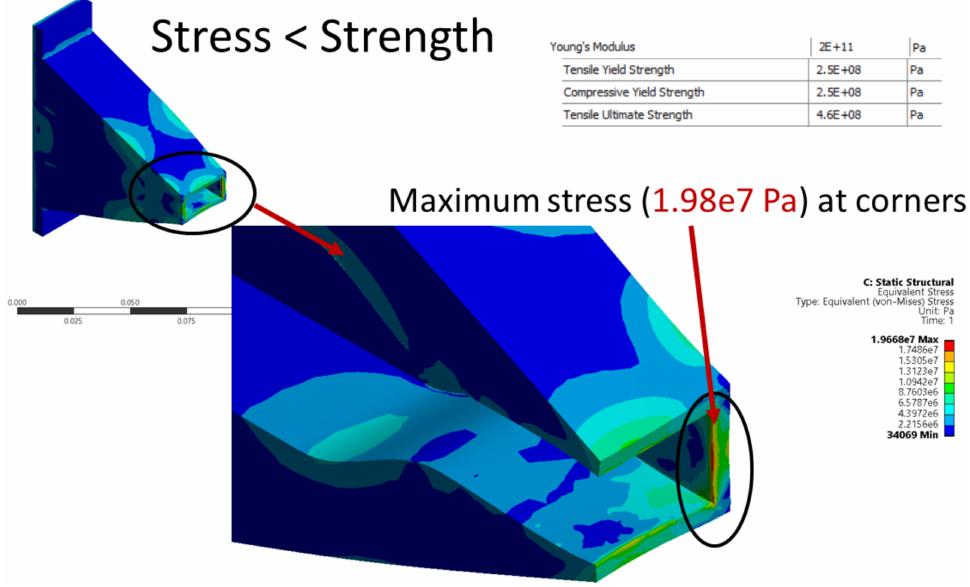
Figure 10. Equivalent (Von-Mises) stress at NPR 4.5 for improved